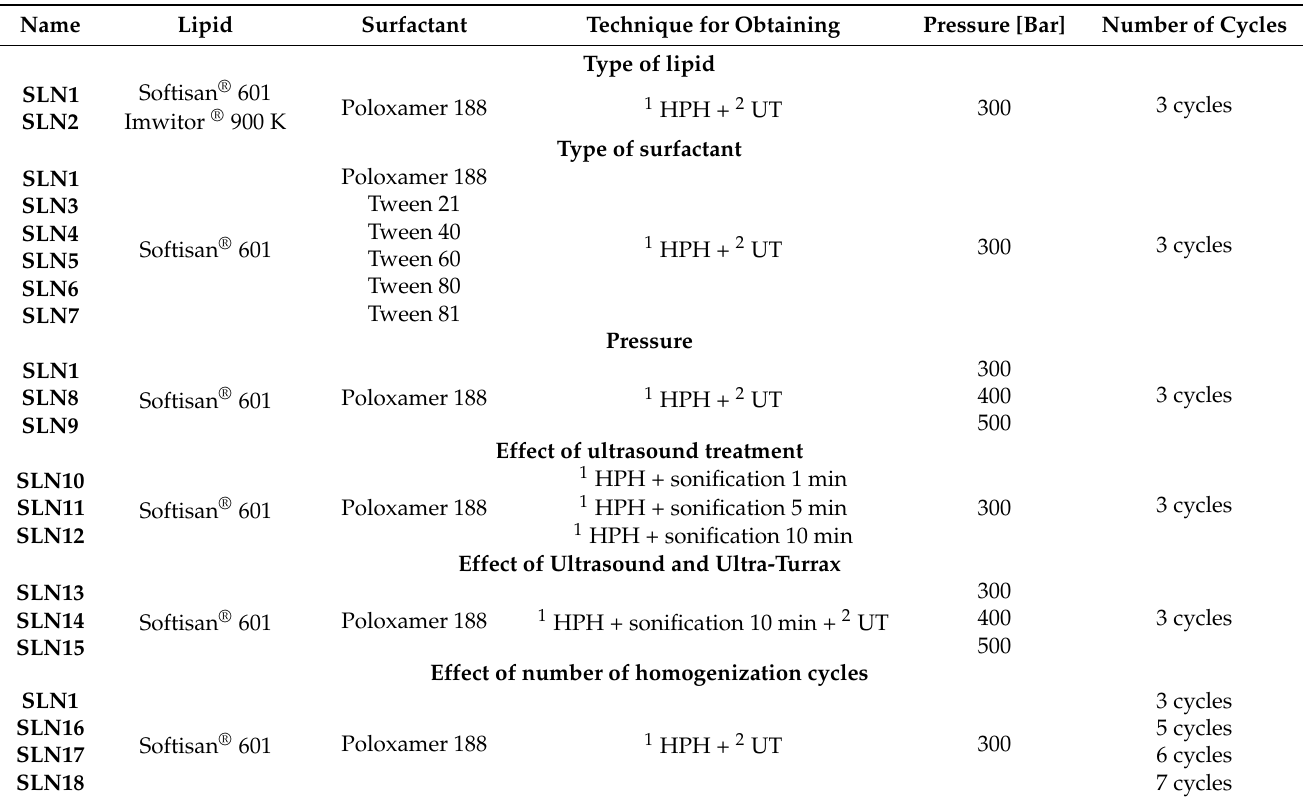
Table 6. Optimization of basic formulation parameters such as lipid and surfactant type and pres- sure; ultrasound; and the effect of the number of homogenization cycles for obtaining solid lipid